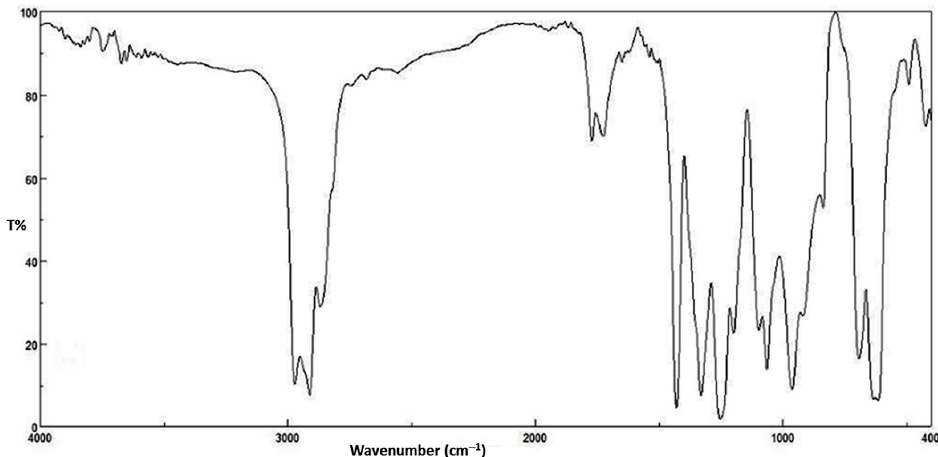
Figure 3. FTIR spectrum of PVC film containing Bu 2 SnL 2 complex after irradiation.